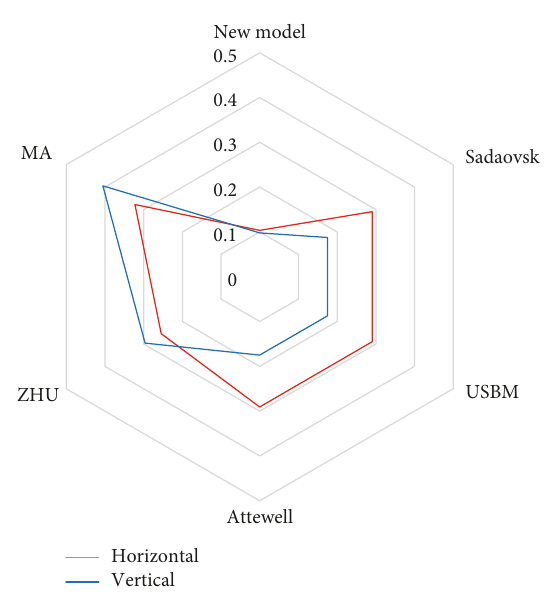
Figure 4: Comparative results between measured and predicted horizontal and vertical